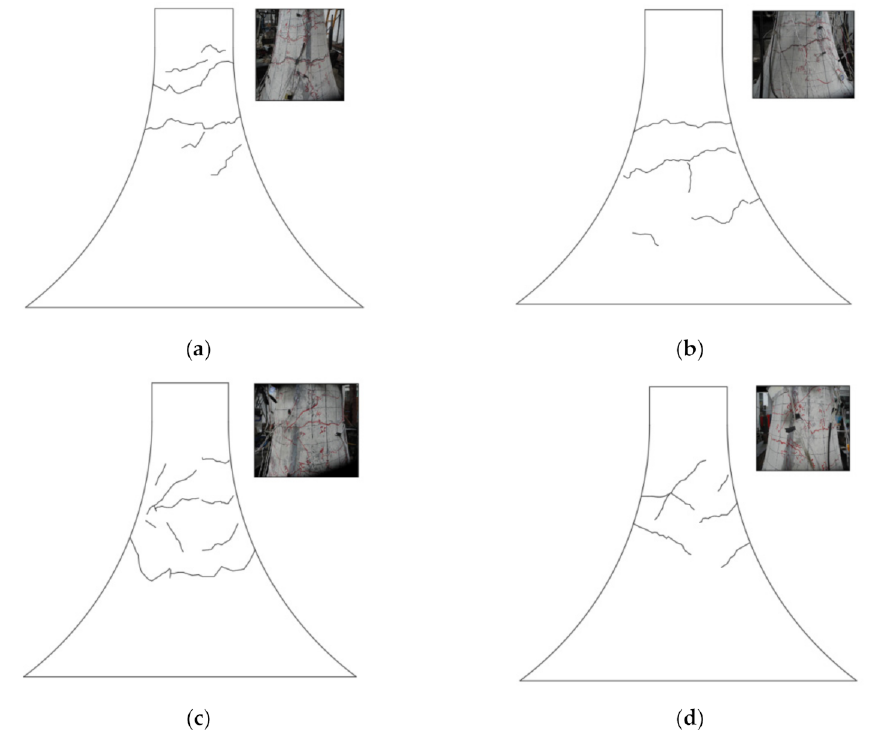
Figure 10. Destruction of GD-3: ( a ) East (forward), ( b ) West (reverse), ( c ) South (left side), and ( d ) North (right side). Table 4. Bearing capacity of prestressed transition